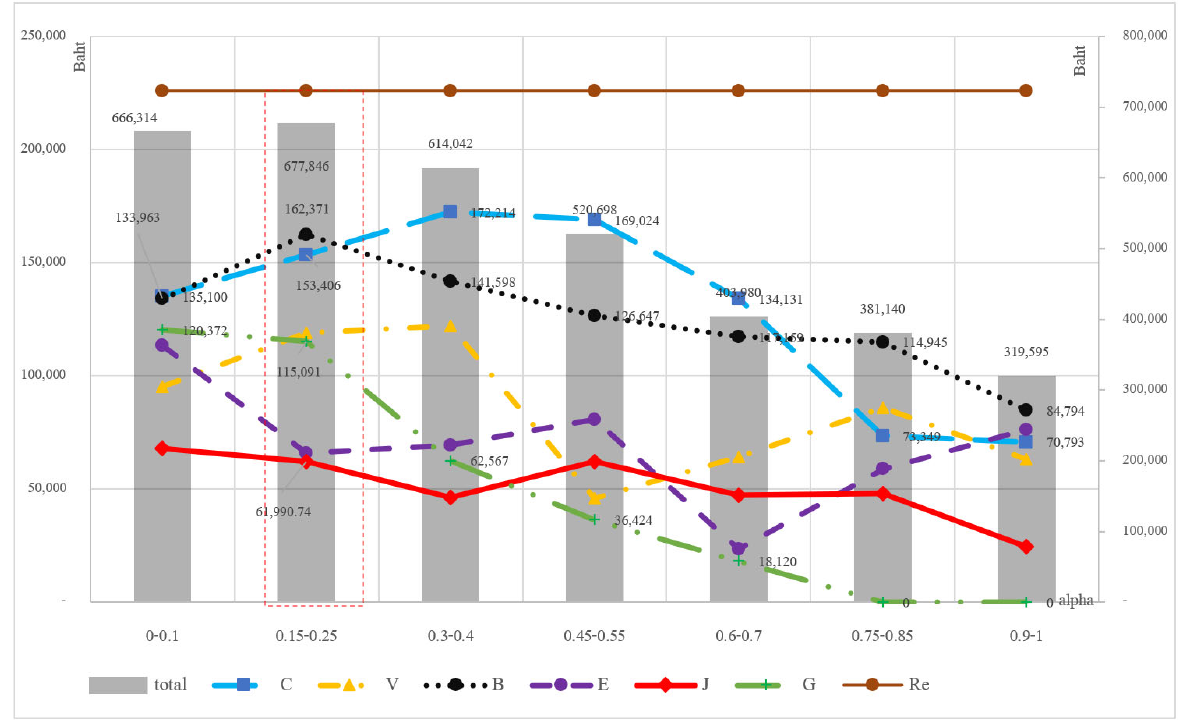
Fig. 2. Total three-year net return at various α prices and yields (at λ = 0.15